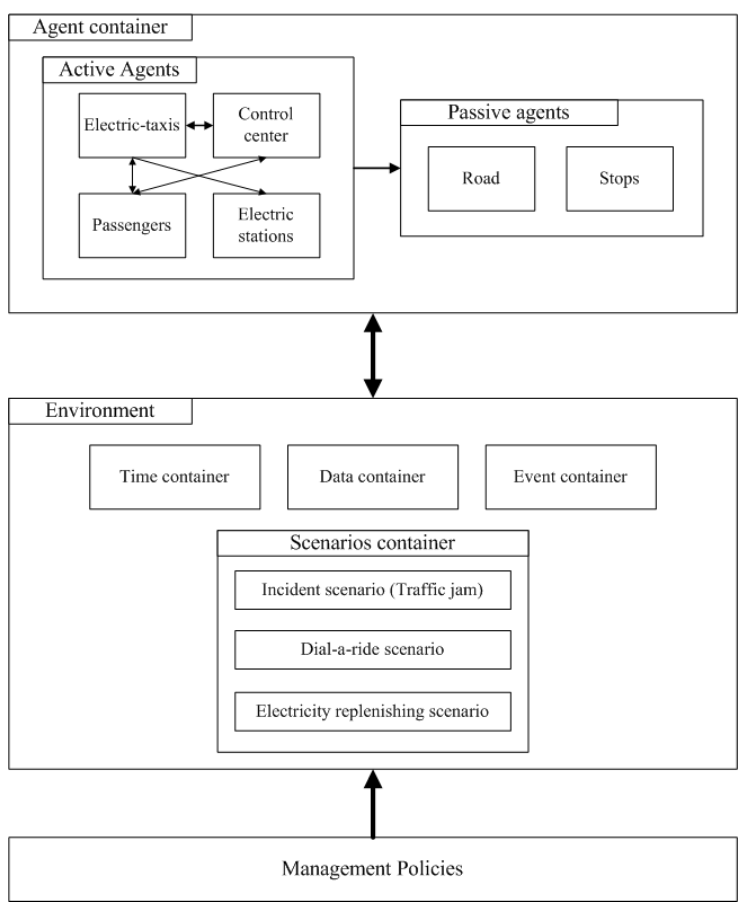
Figure 1. “The framework of electric-taxi DAR operation